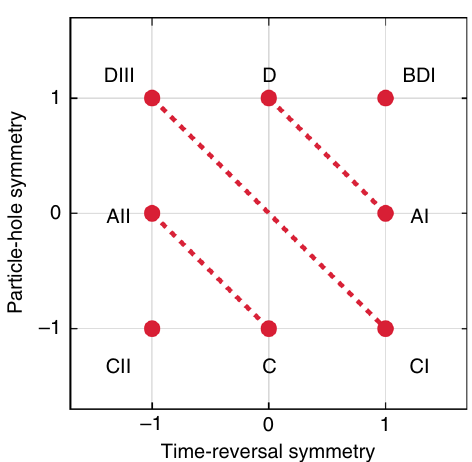
Fig. 2 Altland – Zirnbauer symmetry classes that involve the anti-unitary symmetry (real class). The classes are speci fi ed by the values of T 2 ¼ ± 1 and C 2 ¼ ± 1, and the absence of symmetry is indicated by 0. The class symbol follows Cartan ’ s notation. While there are eight symmetry classes in Hermitian physics, the classes connected by dotted lines are topologically equivalent and thus the symmetry classes reduce to fi ve in non-Hermitian physics. For instance, a non-Hermitian Hamiltonian having time-reversal symmetry with T 2 ¼ þ 1 alone (class AI) and that having particle-hole symmetry with C 2 ¼ þ 1 alone (class D) are equivalent and hence uni fi ed